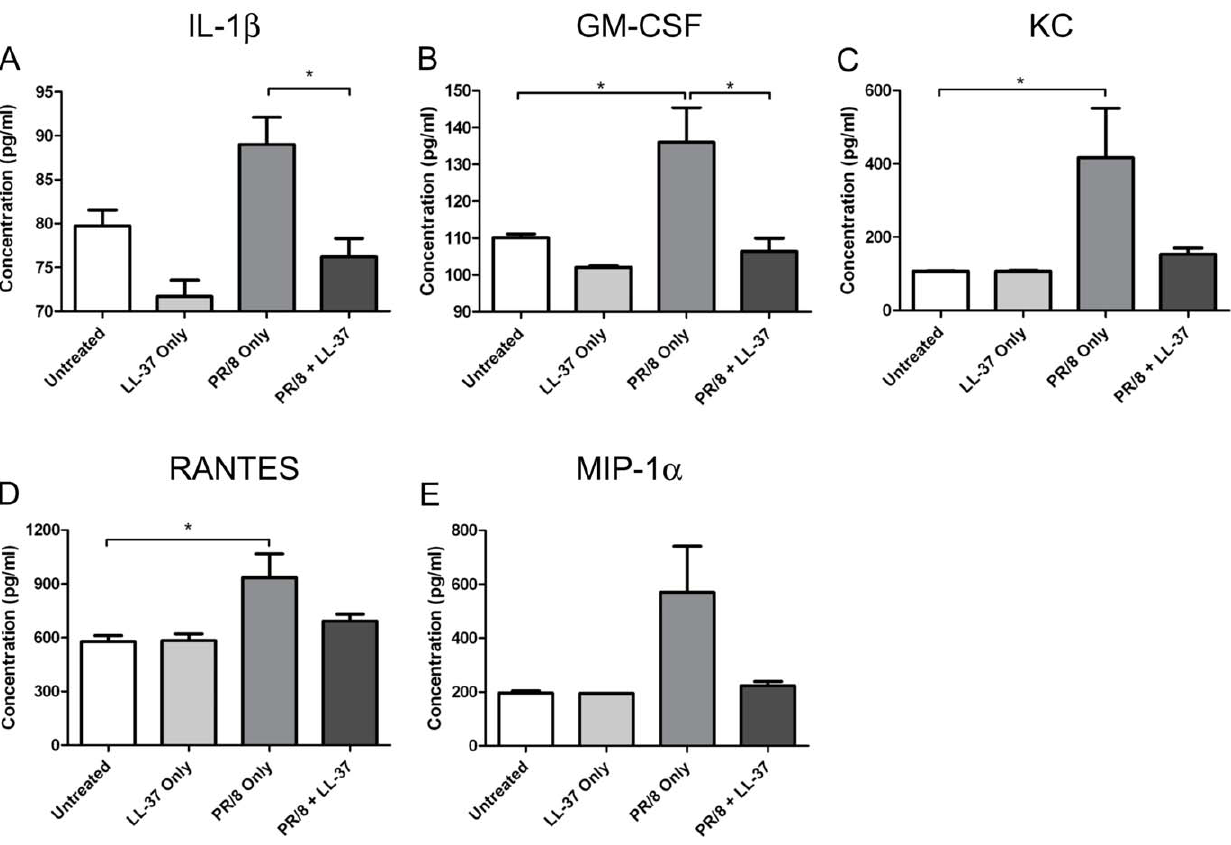
Figure 3. Cathelicidins Mediate Changes in Lung Cytokine Concentrations Following Influenza Virus Infection. Groups of 5 mice were infected with 10 MLD 50 of A/PR/8/34 influenza virus via intranasal administration on day 0. Mice were nebulized with 200 m l of saline (control), or LL- 37 peptide (500 m g/ml) once daily from day -1 to day 2. Mice were euthanized on day 3 and concentration of the indicated cytokines in the bronchoalveolar lavage (BAL) fluid were measured by BioPlex assay. Figures show mean values 6 SEM. Statistical analysis was performed using an two-way analysis of variance (ANOVA) (*P # 0.05).